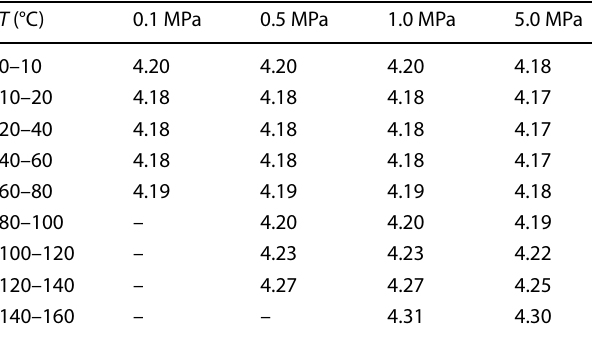
Table 2 Average specific heat at constant pressure